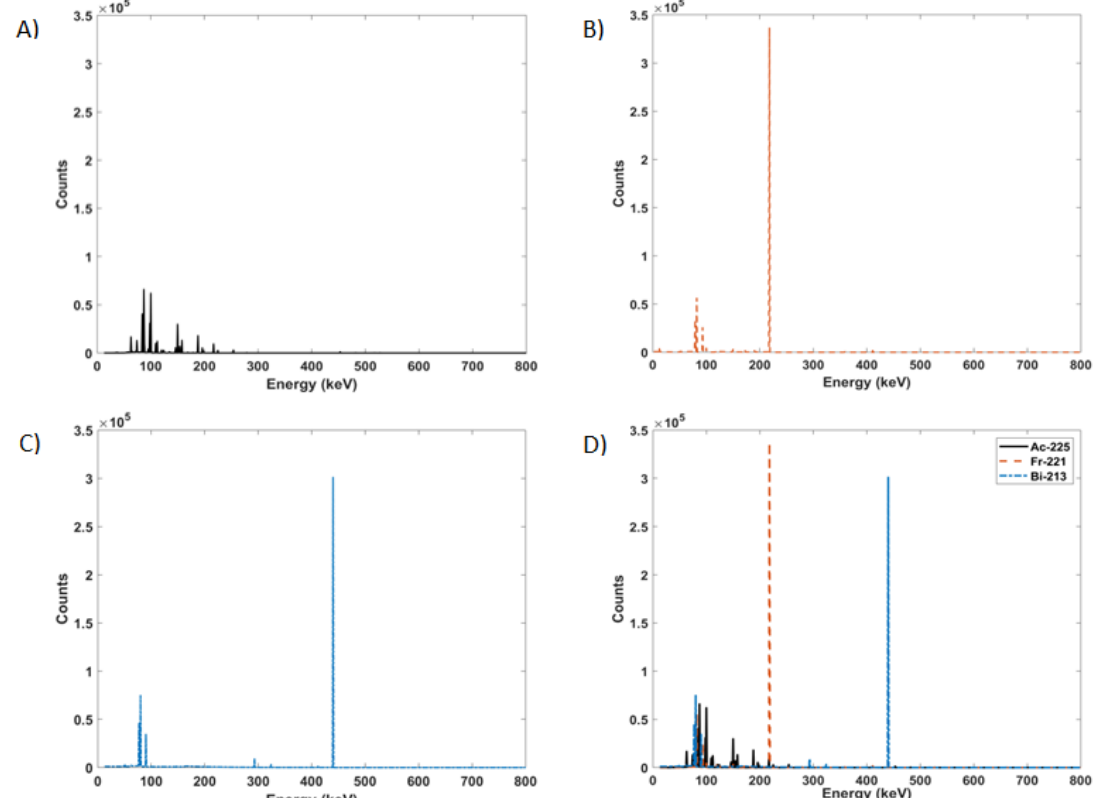
Figure 5. High definition Monte Carlo simulated gamma spectra of ( A ) 225 Ac, ( B ) 221 Fr, ( C ) 213 Bi, and ( D ) all three superimposed.